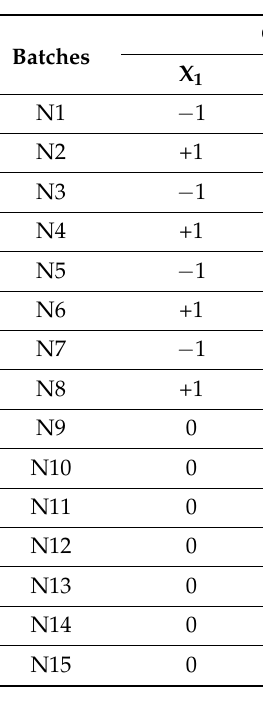
Table 6. Formulation layout of design